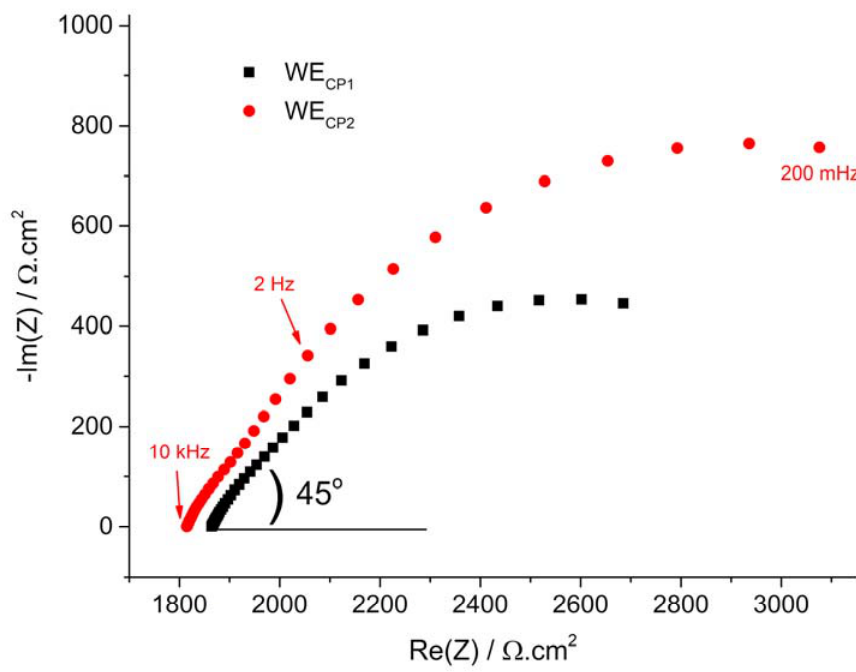
Figure 3. EIS Nyquist at OCP (day 7) for coupons WE CP1 and WE CP2 . The EIS data at OCP were then modelled using the electrical equivalent circuit